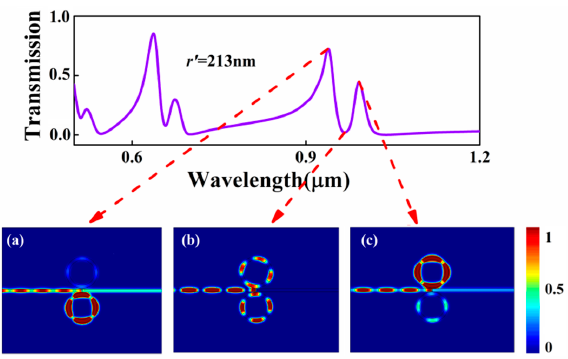
Figure 4. Transmission spectrum of the MIM waveguide with two shunt-wound ring resonators when r ’ = 213 nm; the contour profiles of magnetic intensity distributions | H z | 2 of the device at ( a ) λ = 940 nm; ( b ) λ = 967 nm; ( c ) λ = 991 nm.